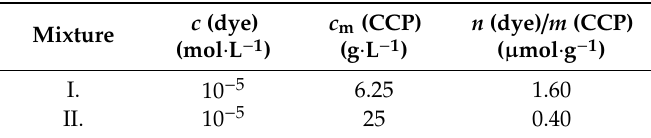
Table 1. Composition of the mixtures of organic dye (rhodamine B or phloxine B) with carbon sample. The volume of the mixtures was always 70 mL. Symbols c (dye) and c m (CCP) denote a concentration of rhodamine B (respectively, phloxine B) and mass concentration of the pulp sample. Symbols n (dye) / m (CCP) corresponds to a dye ratio to the mass of the pulp sample. c (dye) c m (CCP) Mixture (mol · L − 1 )